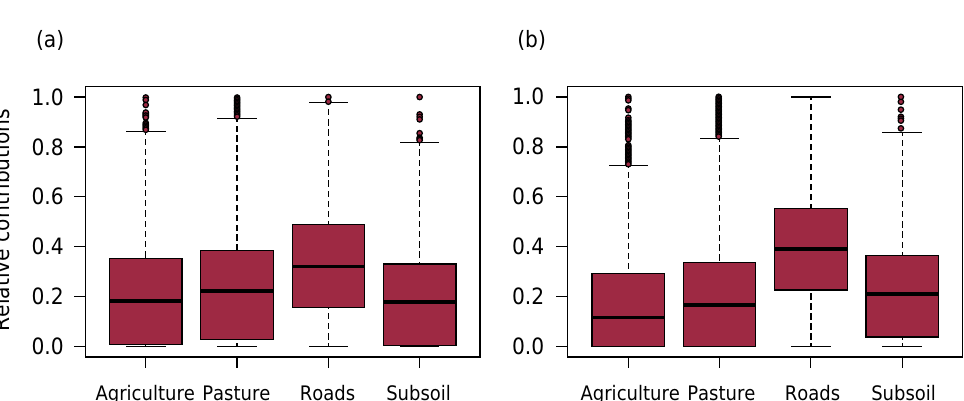
Figure 5. Box plots of relative contributions from each one of the sources of river bed sediment (a) and lag deposits (b) collected downstream from the Posses catchment